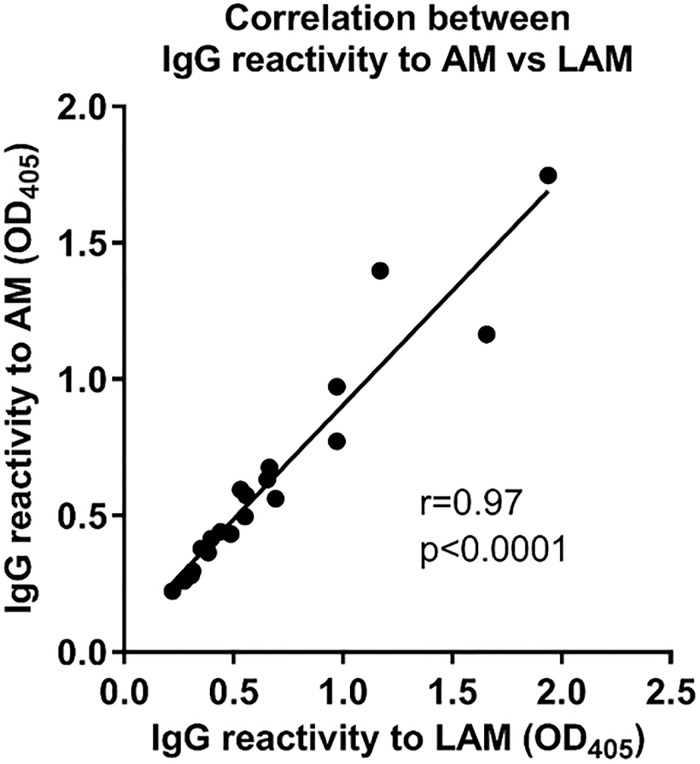
Correlation between IgG response to M. tuberculosis capsular arabinomannan (AM) and cell wall lipoarabinomannan (LAM) in HIV-infected TB patients.Spearman rank correlation.